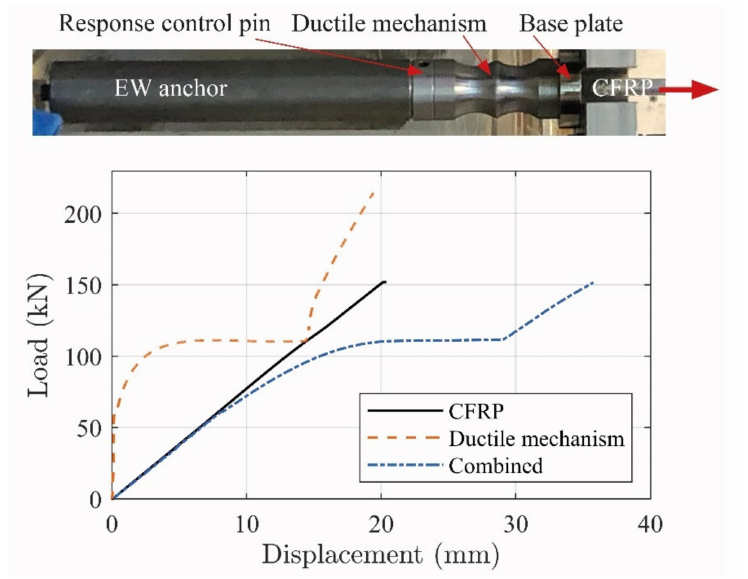
Figure 5. Ductile EW anchorage and related response